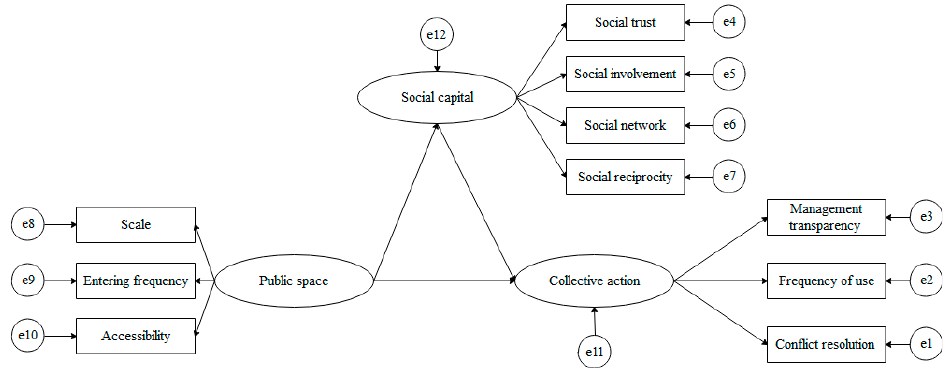
Figure 1. Mediating Effects of Social Capital.